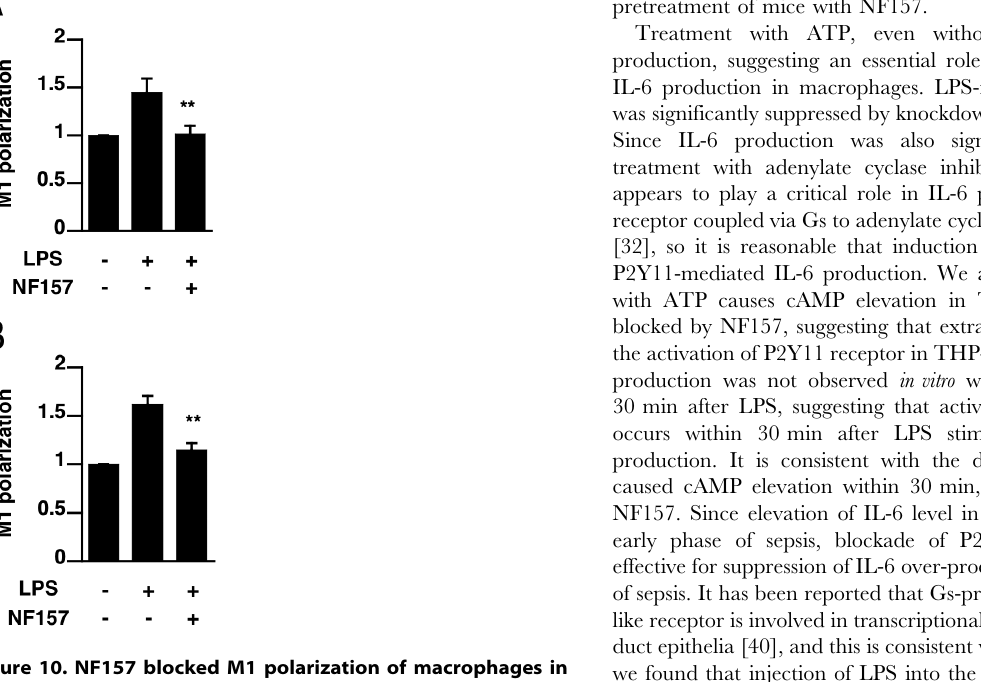
Figure 10. NF157 blocked M1 polarization of macrophages in LPS-treated mice. ( A , B ) Peritoneal and splenic macrophages were isolated from mice 24 h after LPS injection, and analyzed by flow cytometry for the expression of CCR7. Each value represents the mean 6 SE. A significant difference between the positive control group (LPS alone) and the indicated group is indicated by **(p ,